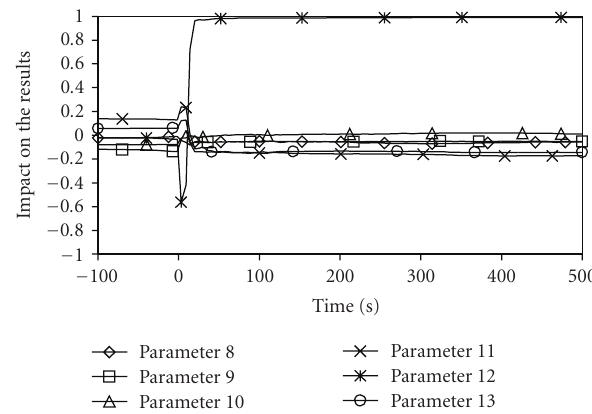
Figure 7: Loss-of-all-MCPs event. The impact of parameters no.8– 13 on the coolant flow rate through one MCC loop. The numbering of parameters is the same as in Table